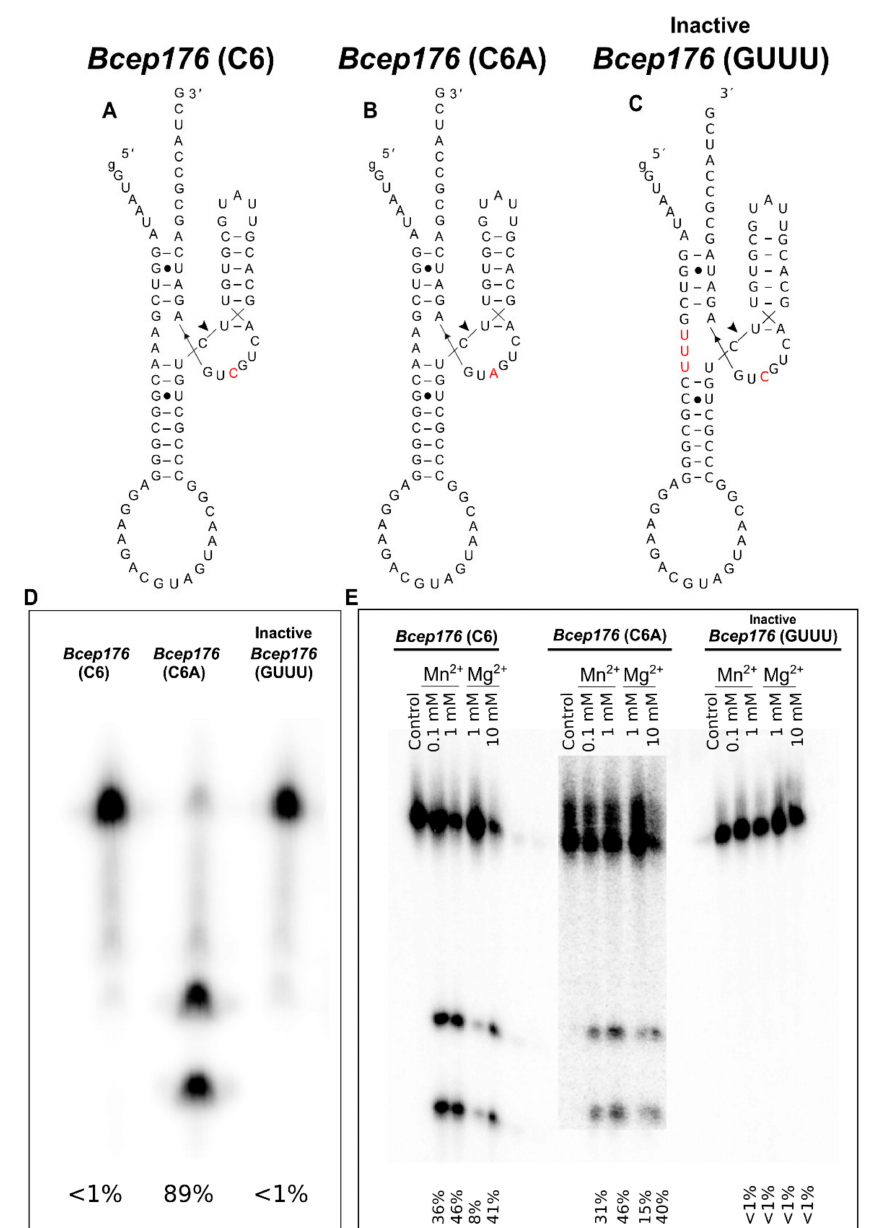
Figure 3. Importance of C6 in the bacteriophage hammerhead ribozyme Bcep176 . ( A ) Native Bcep176 (C6) bears a natural variation from the consensus catalytic core, C6, instead of A6, shown in red. ( B ) Bcep176 (C6A) reversed to “standard consensus” (C6A), in red. ( C ) Introducing a mutation to change GAAA to GUUU in order to inactivate the ribozyme Bcep176. ( D ) Cleavage during in vitro transcription (in the presence of 25 mM Mg 2 + ) for native Bcep176 (C6), mutant Bcep176 (C6A) and inactive Bcep176 (GUUU). ( E ) Cleavage assay of Bcep176 (C6), mutant Bcep176 (C6A) and inactive Bcep176 (GUUU) in the presence of 0.1 mM and 1 mM Mn 2 + compared to 1 mM and 10 mM Mg 2 + . The incubation time was 60 min for all the